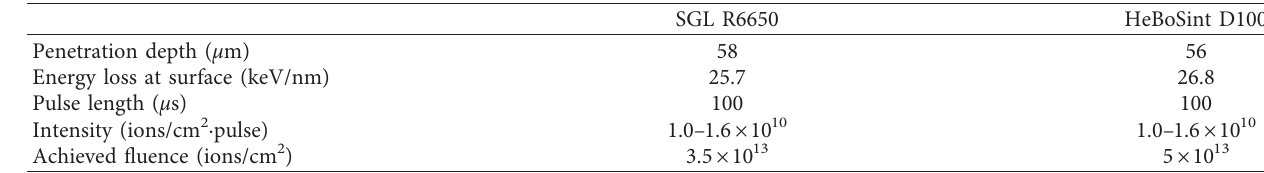
Figure 2: Electronic and nuclear energy loss as a function of penetration depth for 1.14GeV U-ions in a carbon target with a density of 1.84g/cm3 as calculated using the SRIM-2013 code. Table 2: Penetration depth and surface energy loss as calculated with the SRIM-2013 code [25] and beam parameters of isotropic graphite grade SIGRAFINE R6650 and h-BN grade HeBoSint